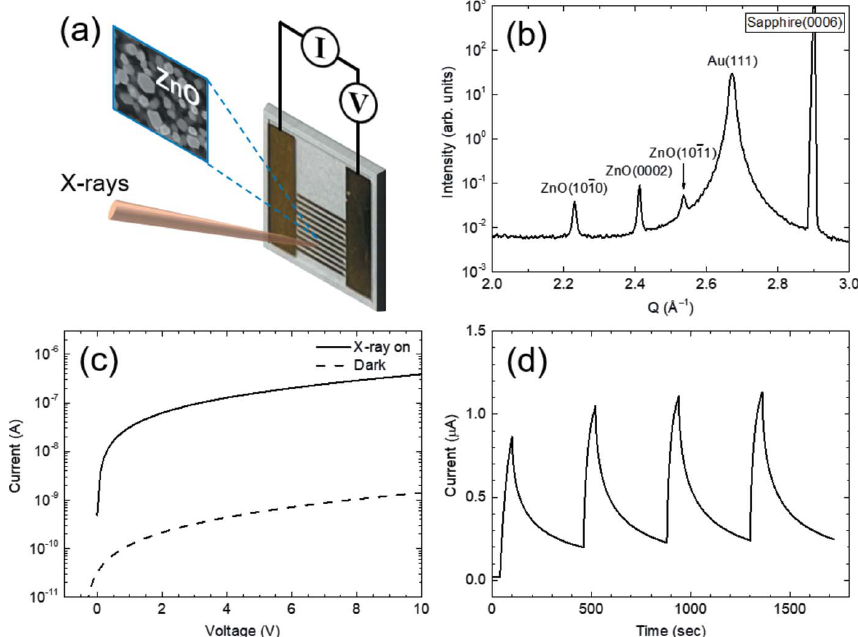
Figure 6 ( a ) Metal–semiconductor–metal type X-ray photodetector. Width and spacing of the metal grids are 200 m m. Top-view SEM image denotes the morphology of the ZnO nanostructures. ( b ) XRD profile of the ZnO nanostructure-based X-ray photodetector. ( c ) X-ray-induced photocurrent and dark current profiles as a function of applied voltage. The photo-to-dark-current ratio at 10 V is approximately 250. ( d ) Sensing profiles for applied voltage of 10 V during repeated X-ray